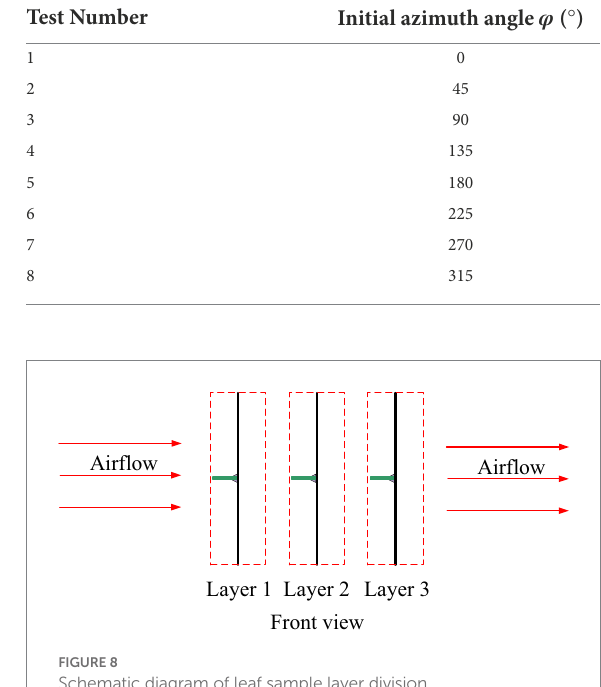
TABLE 2 The technical parameters of the tunnel body and power module.